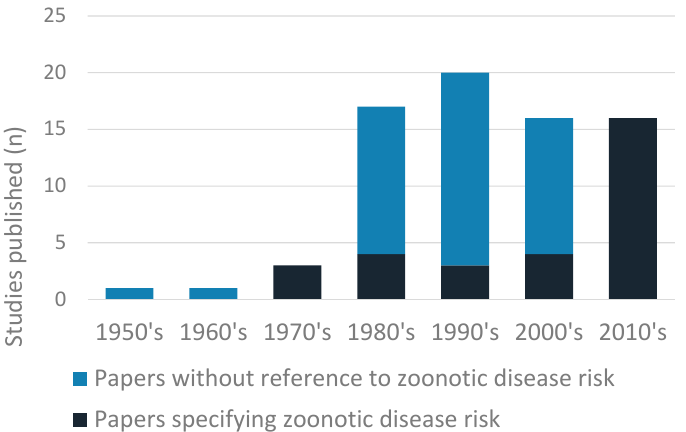
Figure 3. Total number of studies published by decade, showing the number of publications that highlighted the zoonotic risk of the pathogen and those that did not.